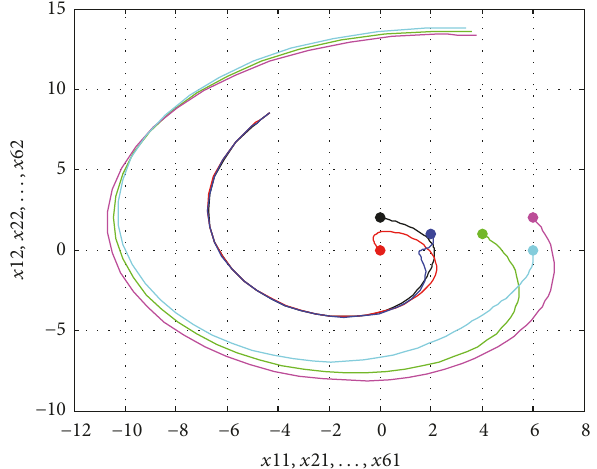
Figure 2: Group consensus motions with 𝑡 ∈ [0,5] . Thick dots denote starting positions.